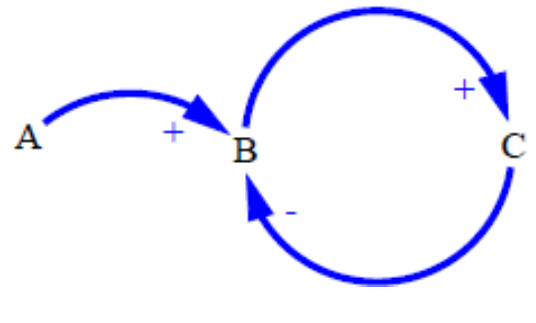
Figure 1. Casual loop diagram